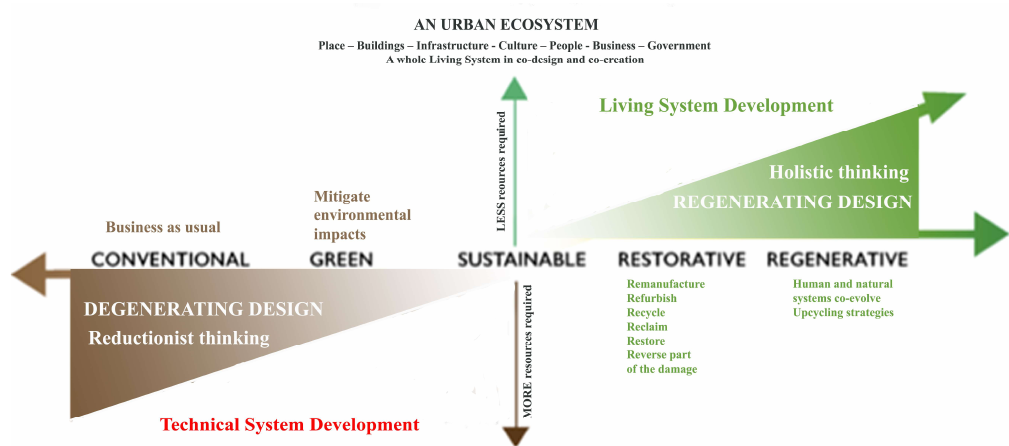
Figure 1. The stages of development, from conventional to regenerative, showing that regeneration goes far beyond sustainability (adapted from References [36,37]).